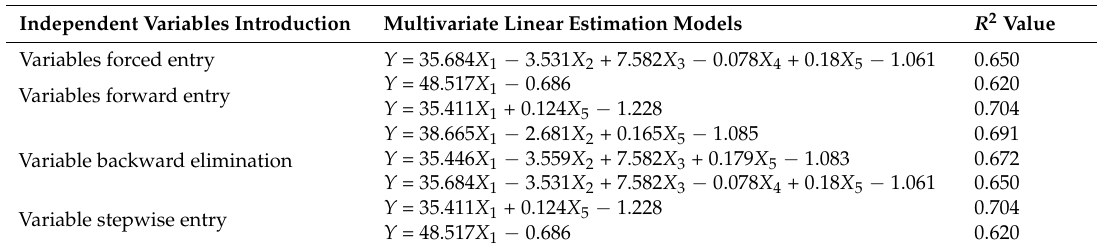
Table 2. Multivariate linear estimation models of wetland vegetation biomass.